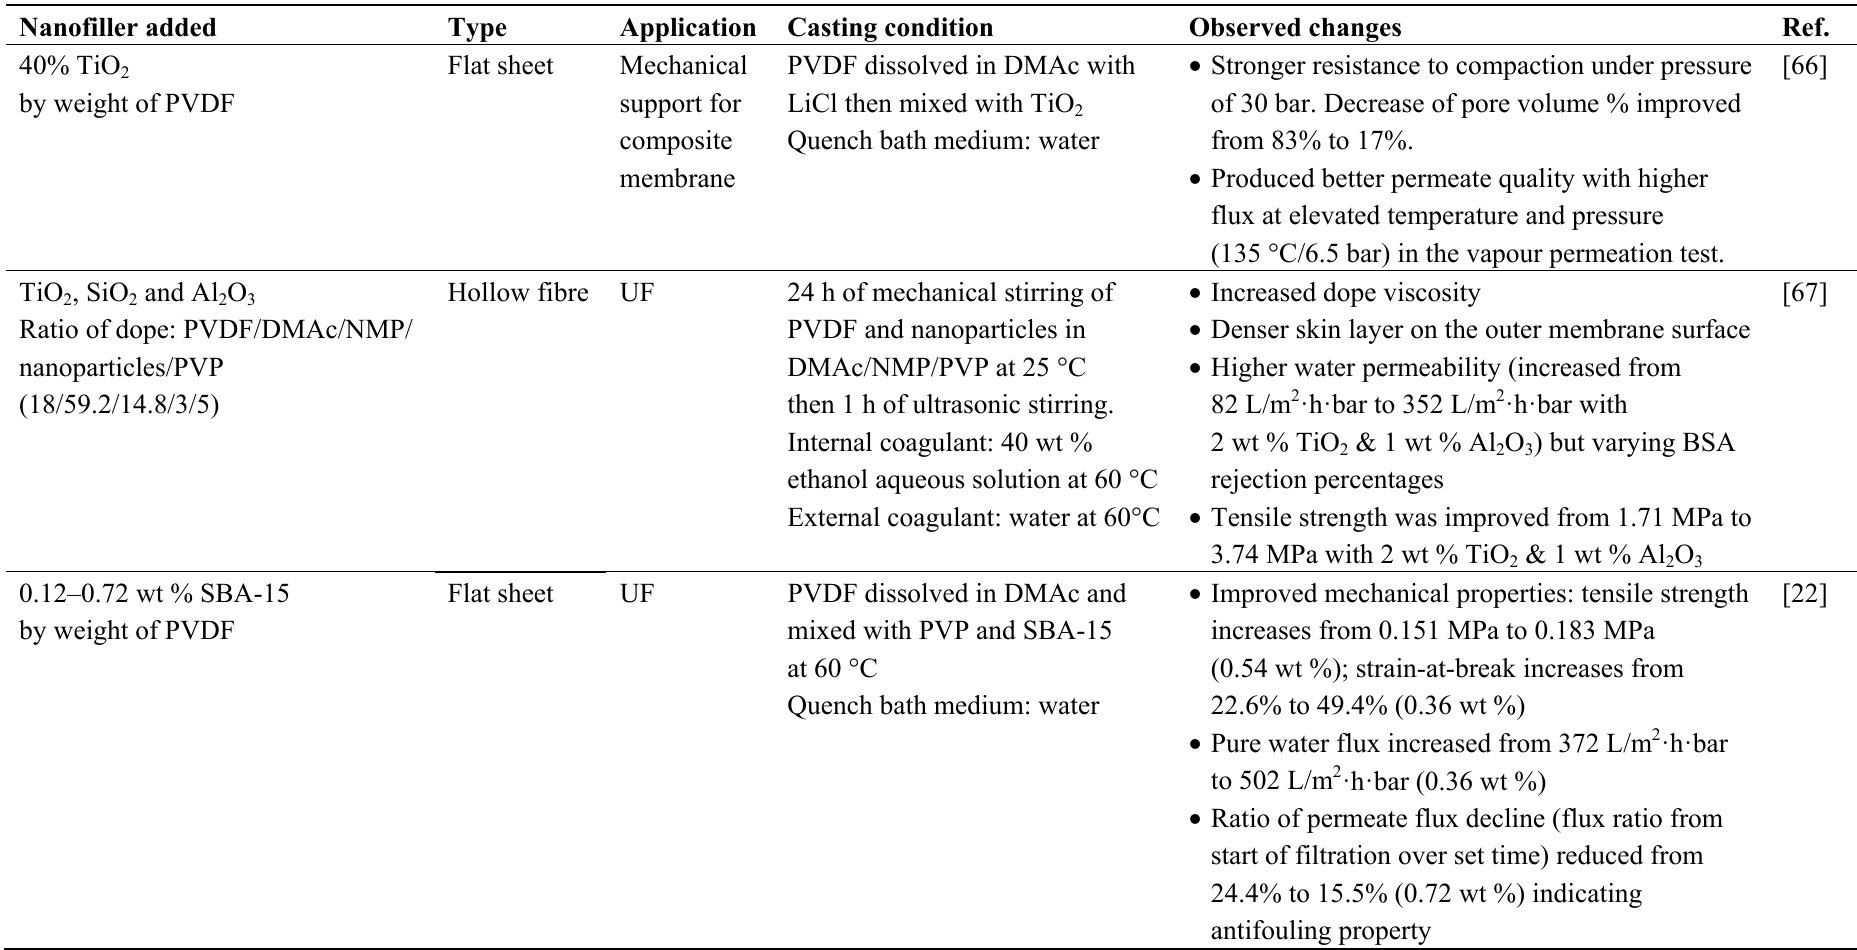
Table 3. Summary of selected PVDF nanocomposite